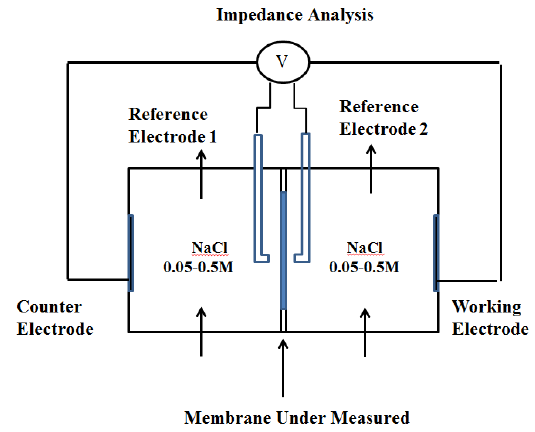
Figure 1. Schematic representation of the experimental setup.